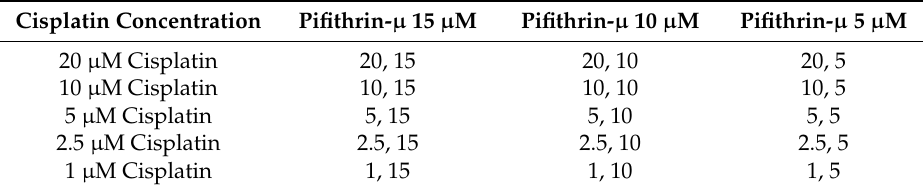
Table 2. Combined drug concentrations investigated against PC-3 prostate cancer cells.